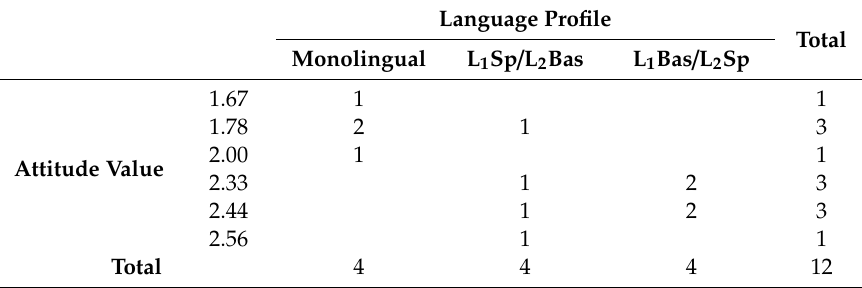
Table 9. Attitudinal values according to the speakers’ language